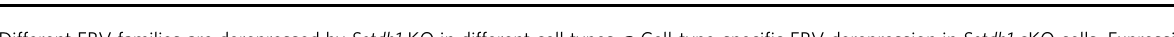
Fig. 1 Different ERV families are derepressed by Setdb1 KO in different cell types. a Cell-type-speci fi c ERV derepression in Setdb1 cKO cells. Expression of ERV families in Setdb1 cKO ESC (day 6 after treatment with 4OHT (KO) or no treatment (WT)) 4 , iMEF (day 5 after treatment with 4OHT (KO) or no treatment (WT)), and E14.5 forebrain cells from WT and Emx2 -Cre: Setdb1 fl / fl mice (KO) 18 . For GMP and LSK cells, bone marrow cells from Rosa -CreERT: Setdb1 cKO mice were transplanted into irradiated recipient mice, GMP and LSK cells were then isolated after injection of 4OHT for 2 weeks (KO) or control injection (WT) 20 . Only ERVs derepressed ( ≧ 2 fold) in at least one of the analyzed cell types with Setdb1 KO are listed. Heatmap indicates the relative expression level of representative ERV families (the RPKM value). The ERVs derepressed ( ≧ 1.5 fold) in Setdb1 KO iMEFs are highlighted in red. b H3K9me3 intensity pro fi les on different ERV families in different cell types. NGS plots show the fold enrichment of H3K9me3 from − 5 kb to 10 kb around genomic ERV elements in ESC, forebrain, iMEF, and GMP. We selected ERVs containing -int element with fl anked LTRs (See Methods). Position 1 is 5 ′ start site of the -int element. Positions of LTRs and int for each ERV element are indicated below the plots. c Bar plots showing the loss of H3K9me3 in ERV families in Setdb1 KO (day 7 after 4OHT treatment: red bar) vs. WT (black bar) iMEF. The y axis indicates the fold enrichment of normalized ChIP read density relative to input. ERV names written in green are analyzed in Fig. 1b. d ChIP-qPCR of H3K9me3 in the Gapdh promoter region indicated ERVs and major satellite (Major S) loci of Setdb1 cKO ESCs and iMEFs. Values are means ± s.d. from independent experiments ( n = 3). *0.005< P < 0.05, **0.0005 < P < 0.005, Student ’ s t